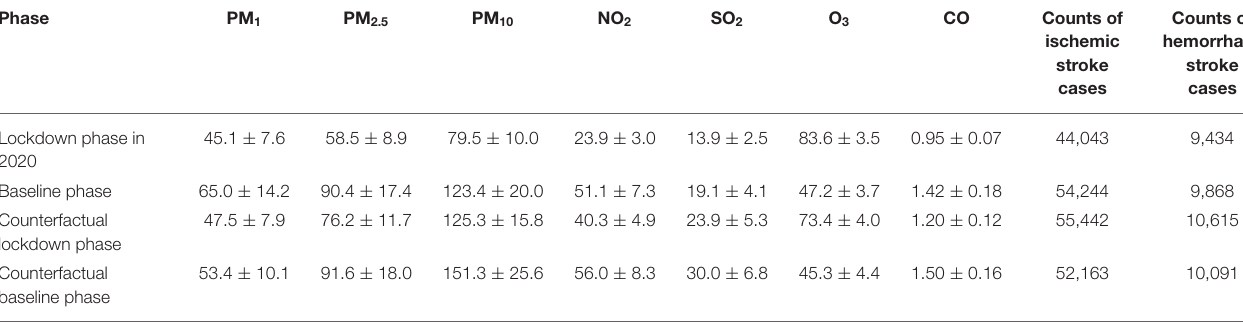
TABLE 1 | Means and standard deviations (SD) for air pollutant concentration levels and counts of stroke cases for the four phases. Phase PM 1 PM 2.5 CO Counts of